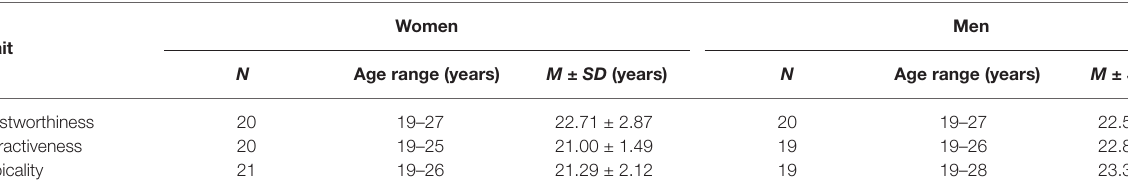
TABLE 1 | Demographic details of the participants.